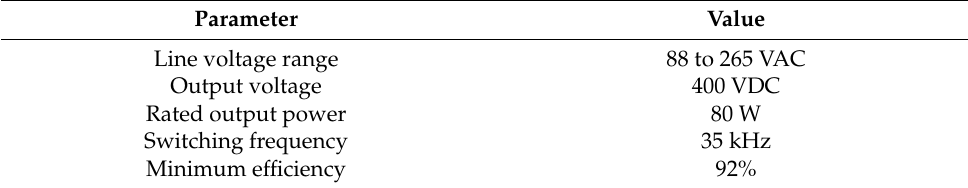
Table 1. STMicroelectronics STEVAL-ISA102V2 Boost PFC converter